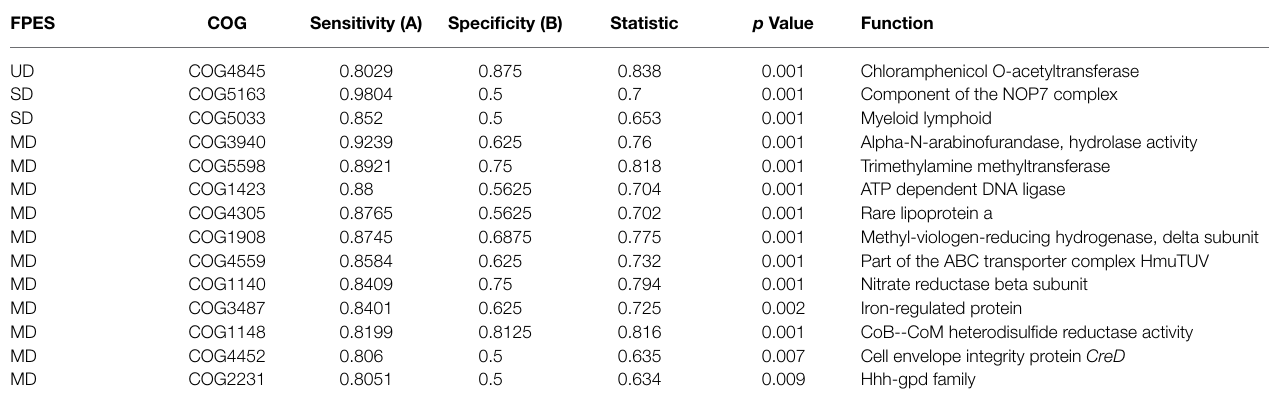
TABLE 4 | Highly sensitive and specific indicator functions from EggNOG